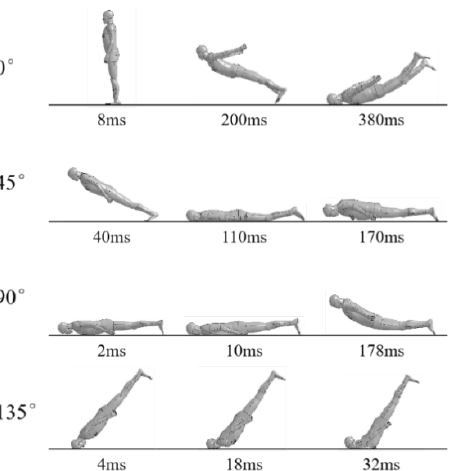
Figure 3. Typical landing kinematics in PFOx+.